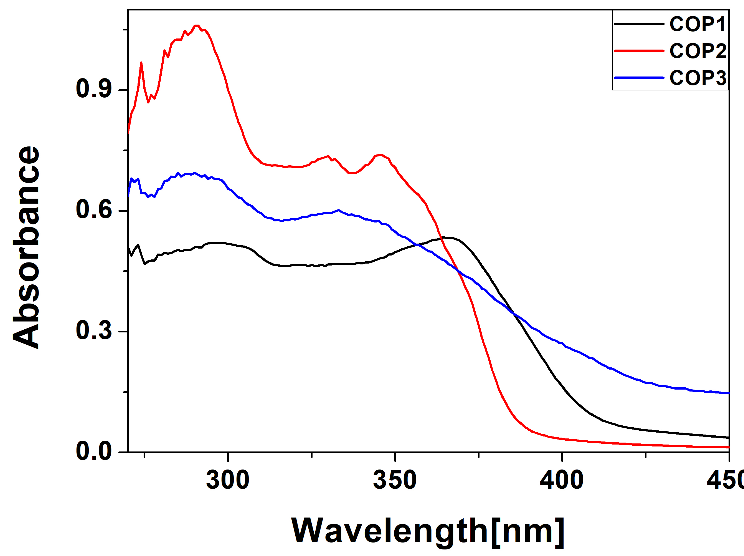
Figure 5. Absorbance spectra of styrylquinoline copolymers.